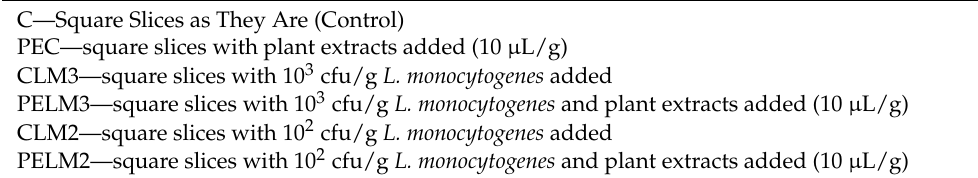
Table 2. Inoculation trials in cooked ham slices. C—Square Slices as They Are (Control) PEC—square slices with plant extracts added (10 µ L/g) CLM3—square slices with 10 3 cfu/g L. monocytogenes added PELM3—square slices with 10 3 cfu/g L. monocytogenes and plant extracts added (10 µ L/g) CLM2—square slices with 10 2 cfu/g L. monocytogenes added PELM2—square slices with 10 2 cfu/g L. monocytogenes and plant extracts added (10 µ L/g)